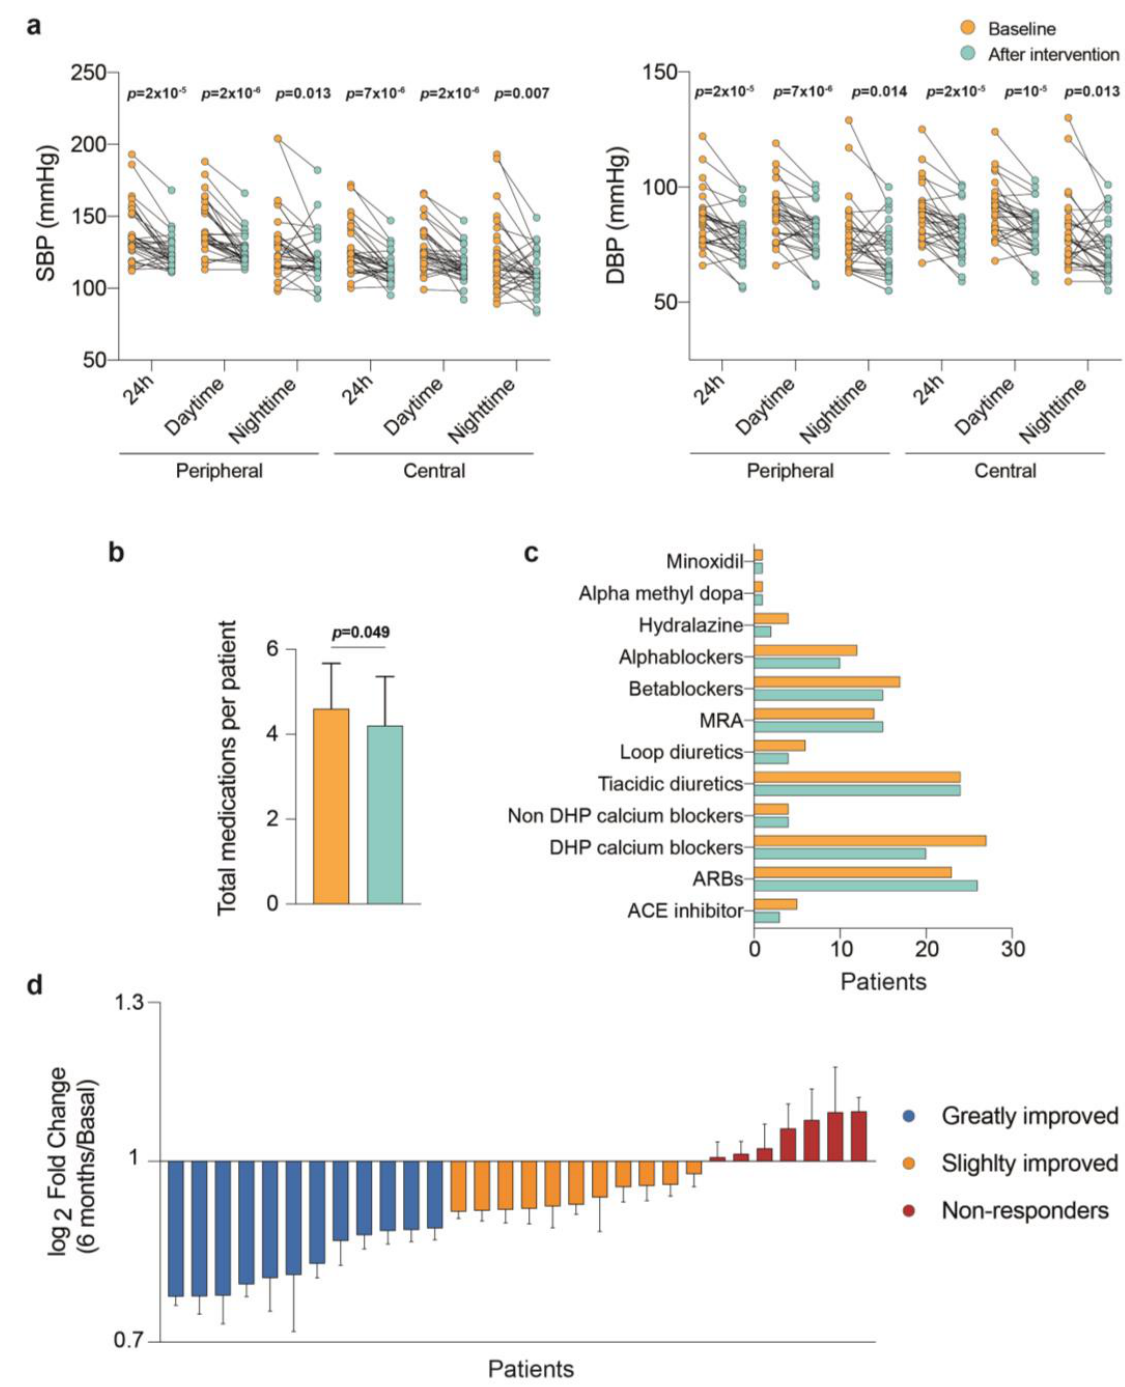
Figure 1. Lifestyle interventions decrease blood pressure in patients with resistant hypertension, but the response was not homogeneous. ( a ) Individual changes in systolic (SBP) and diastolic (DBP) blood pressure, ( b , c ) changes in medication burden from baseline to after intervention, ( d ) the response to intervention was not homogeneous.